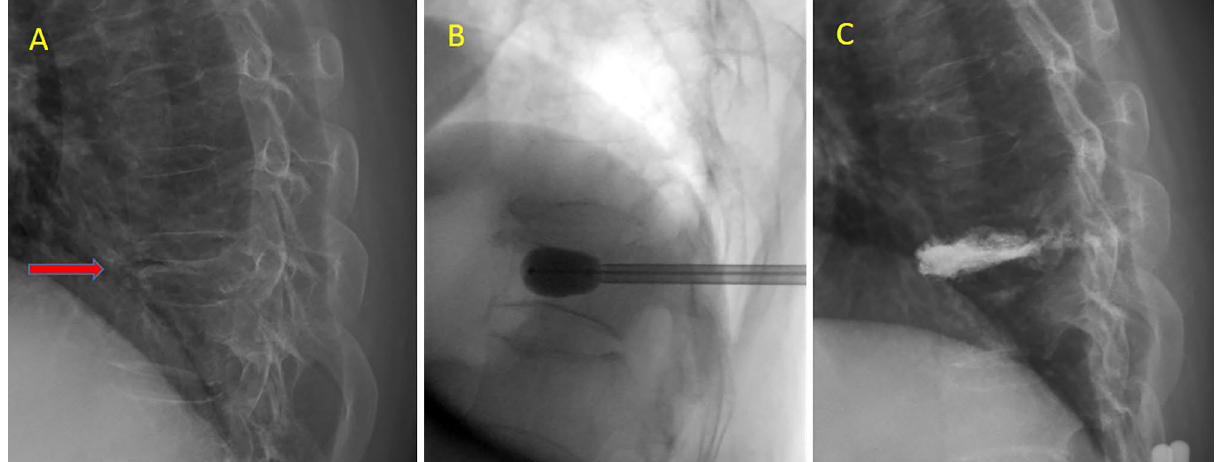
Figure 3. A case of T9 vertebral compression fracture treated with low-viscosity cement balloon kyphoplasty. ( A ) The arrow in the preoperative lateral radiograph points to the fracture level. ( B ) Intraoperative radiograph shows the balloon inflated in the fractured vertebrae. ( C ) Postoperative lateral radiograph demonstrates cement filled in the fractured